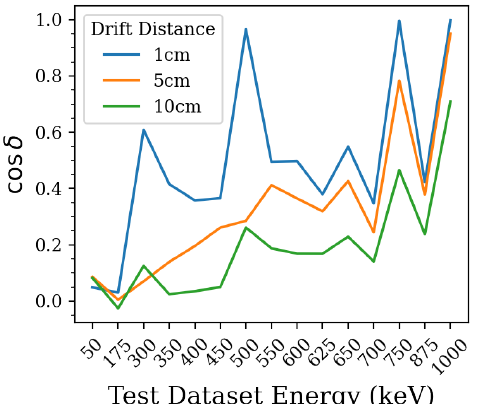
Figure 9. Error for initial direction models trained on the 200 µ m pitch data across energies 300, 500, 750, and 1000 keV and drift lengths 1, 5, and 10 cm. Models are tested on energies present in both the training data set (300, 500, 750, 1000 keV) and outside it. We only plot the median of the cosine of the error cos δ from the 5000 test tracks; larger cos δ implies more accurate